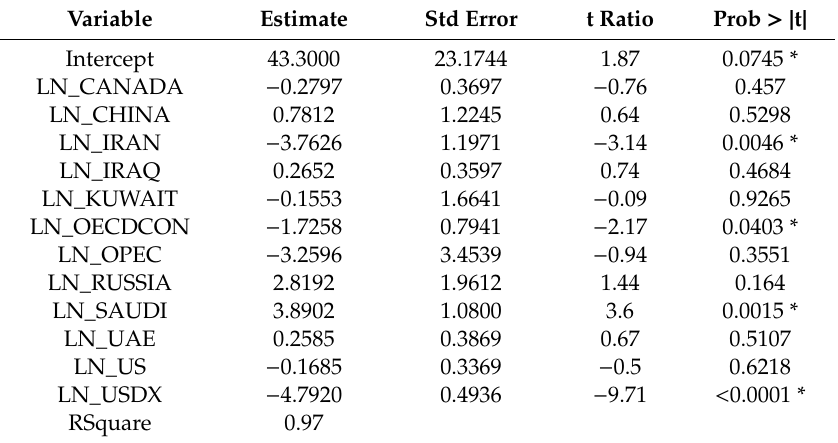
Table 12. Panel 4 period (2007–2009): LN_BRENT prediction-parameter